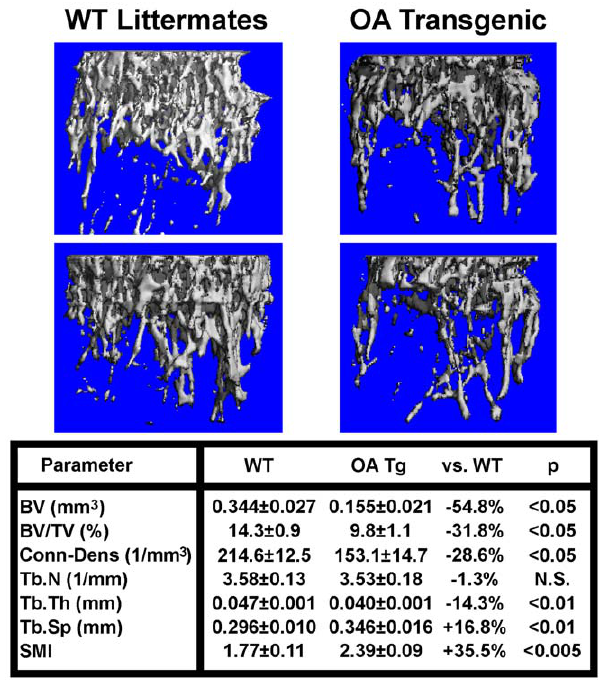
Figure 5. Comparison of m -CT bone parameters at the secondary spongiosa of 4-week-old female OA -Tg mice with those of 4-week-old female WT littermates. Top panels show the three-dimensional reconstruction of bone structure by m -CT at the secondary spongiosa of two representative OA -Tg mice (right) and two WT littermates (panel). Bottom summarizes and compares the various m -CT bone parameters of a group of four OA -Tg mice with a group of four WT littermates.